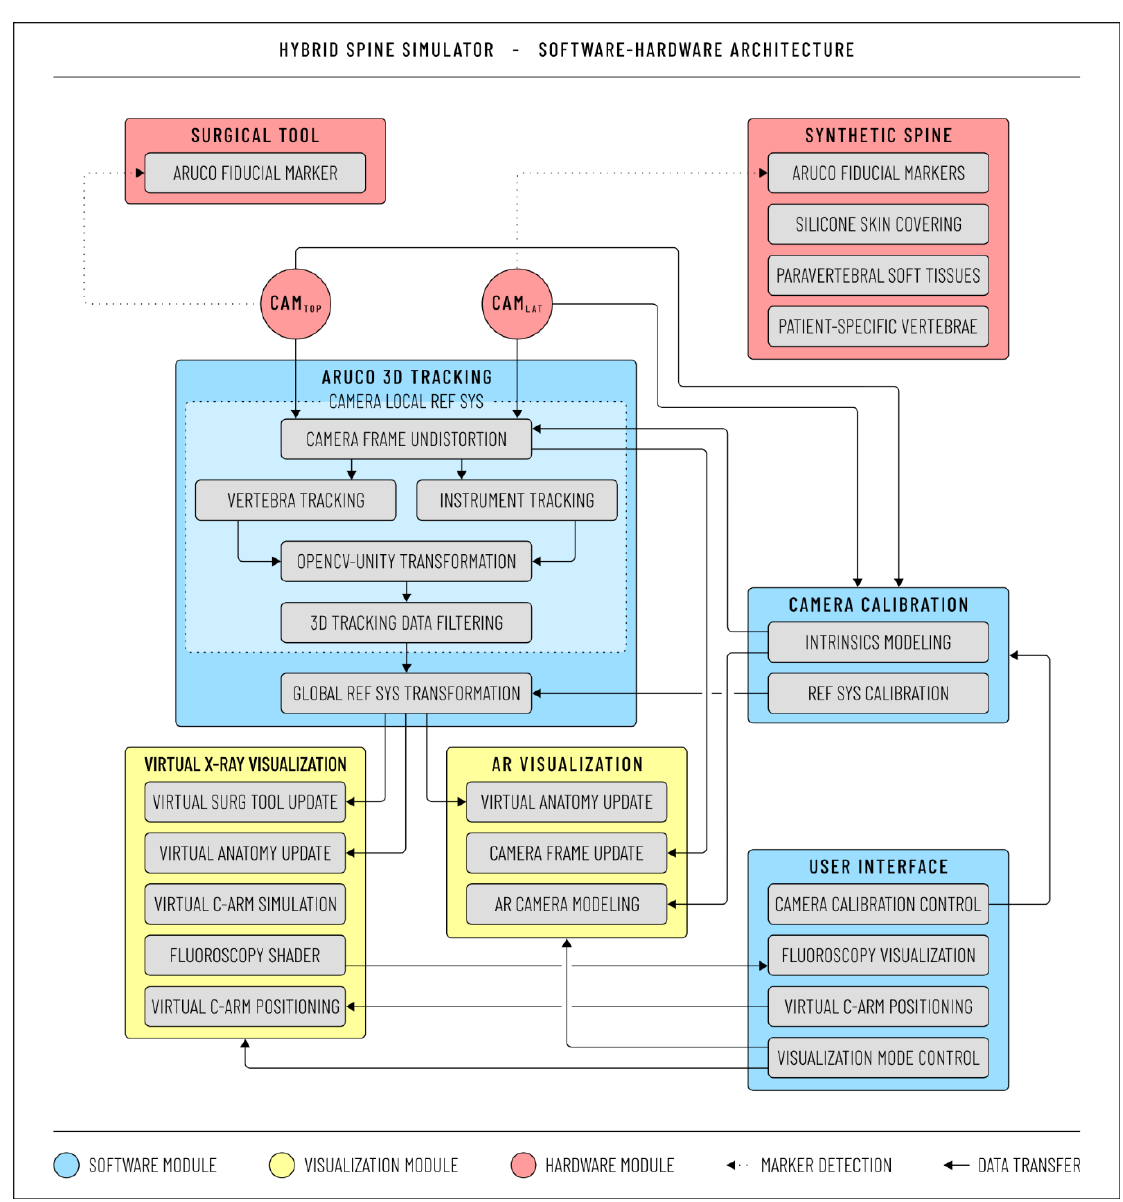
Figure 3. Architecture of the simulator. The Hardware module consists of two cameras, a synthetic spine, and surgical tools with ArUco fiducial markers. The simulator also includes: the Camera Calibration module to model the projection matrix of the two cameras; the ArUco calibration module to track the spine and the surgical instrumentations; the User Interface to load the cameras’ intrinsics, to control the virtual C-Arm and the visualization modules, and to visualize the generated images; the Virtual X-Ray and the augmented reality (AR) visualization module to generate and update the fluoroscopic images and the AR view.